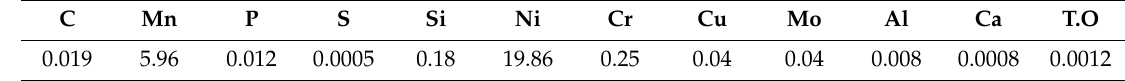
Table 1. Chemical compositions of casting slab,